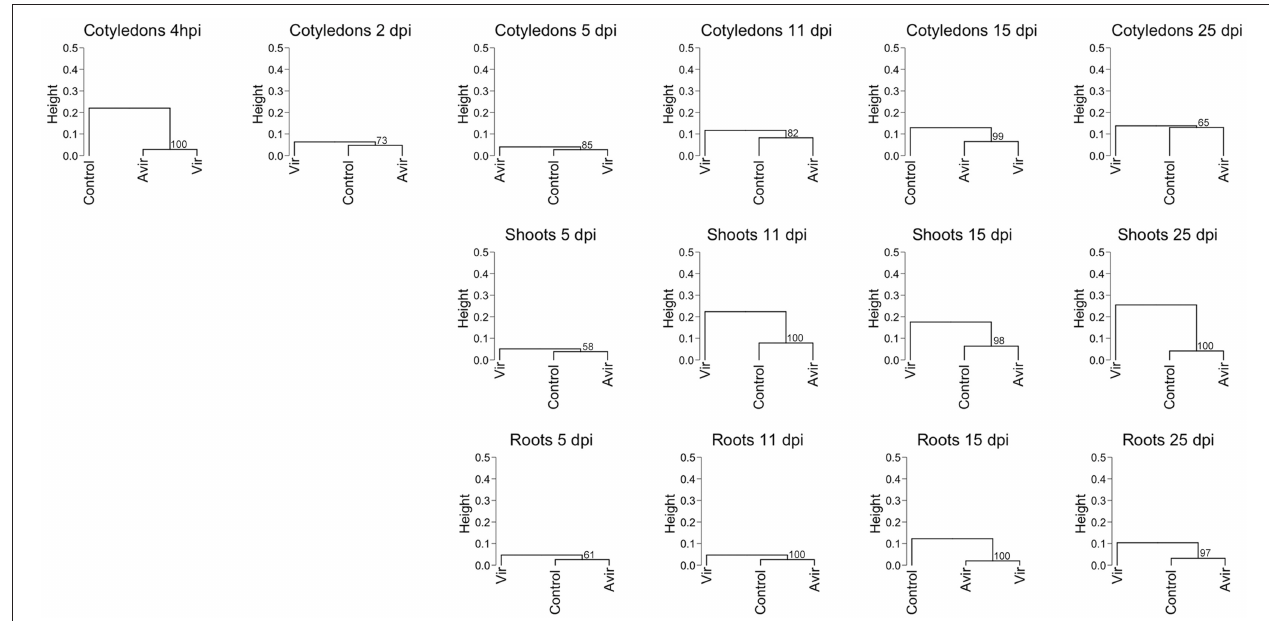
FIGURE 1 | Hierarchical clustering of cytokinin content in pea cotyledons, shoots and roots inoculated with avirulent R. fascians strain 589, virulent strain 602 and mock inoculated control. Cluster analysis is based on cytokinin type and level detected in cotyledons at 4h post-inoculation, and 2 days post-inoculation (dpi), and in cotyledons, shoots and roots from 5 to 25 dpi from four biological replicates. Dendrograms were constructed using Pearson correlation coefficients for the distance matrix and average linkage as the clustering method of log-transformed data, with bootstrapping of 1,000 iterations. Height represents the distance between nodes—the greater the height the greater the dissimilarity between treatments. Numbers in red indicate the unbiased approximate p -values (%), computed by multiscale bootstrap resampling using the pvclust R package ( Suzuki and Shimodaira, 2006).